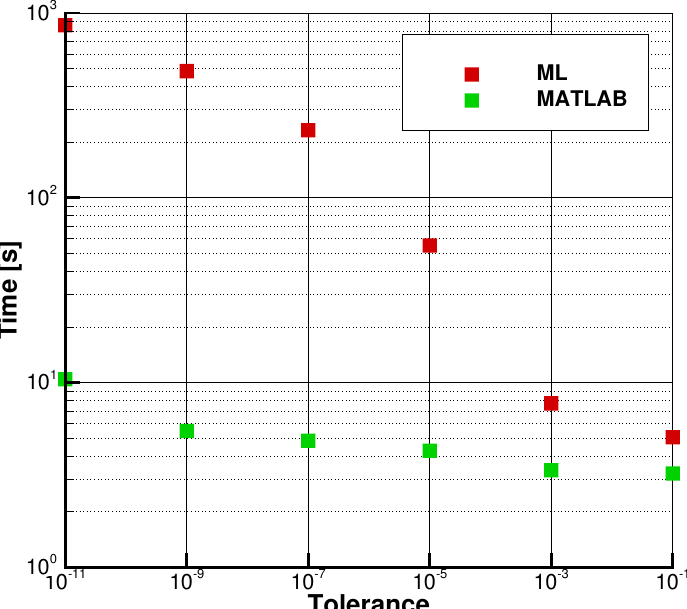
Figure 7. Comparison of Matlab and machine learning time-to-solution for the 1D reacting flow behind the shock wave in state-to-state approach for binary N 2 /N mixture. The machine learning call is performed within the ODE system integration before the matrix